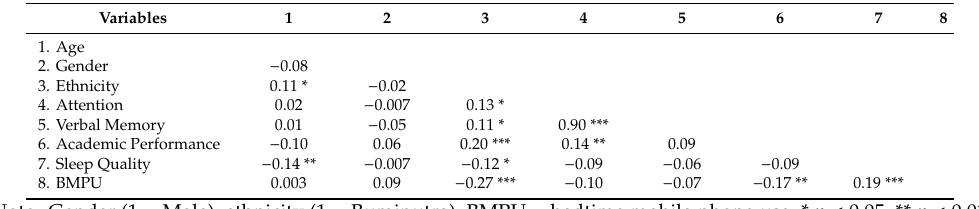
Table 2. Intercorrelations among study variables ( n =